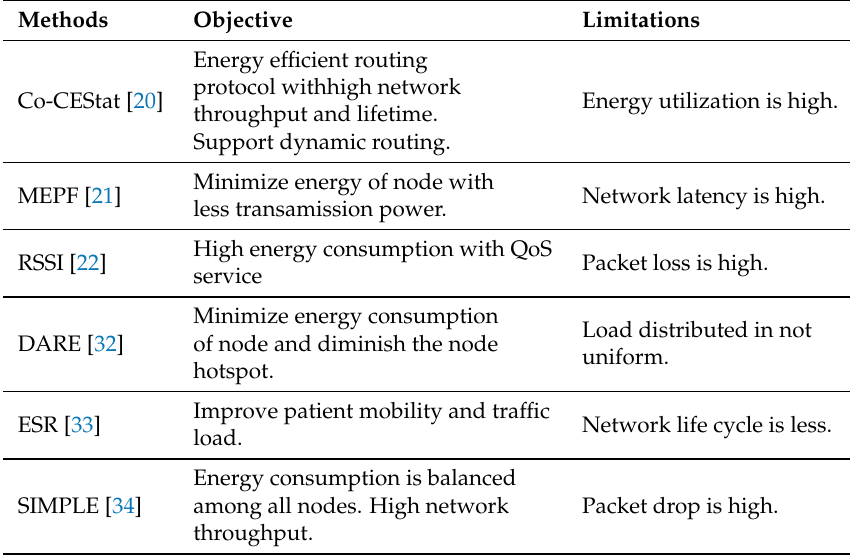
Table 1. State-of-the-art analysis of energy-aware routing